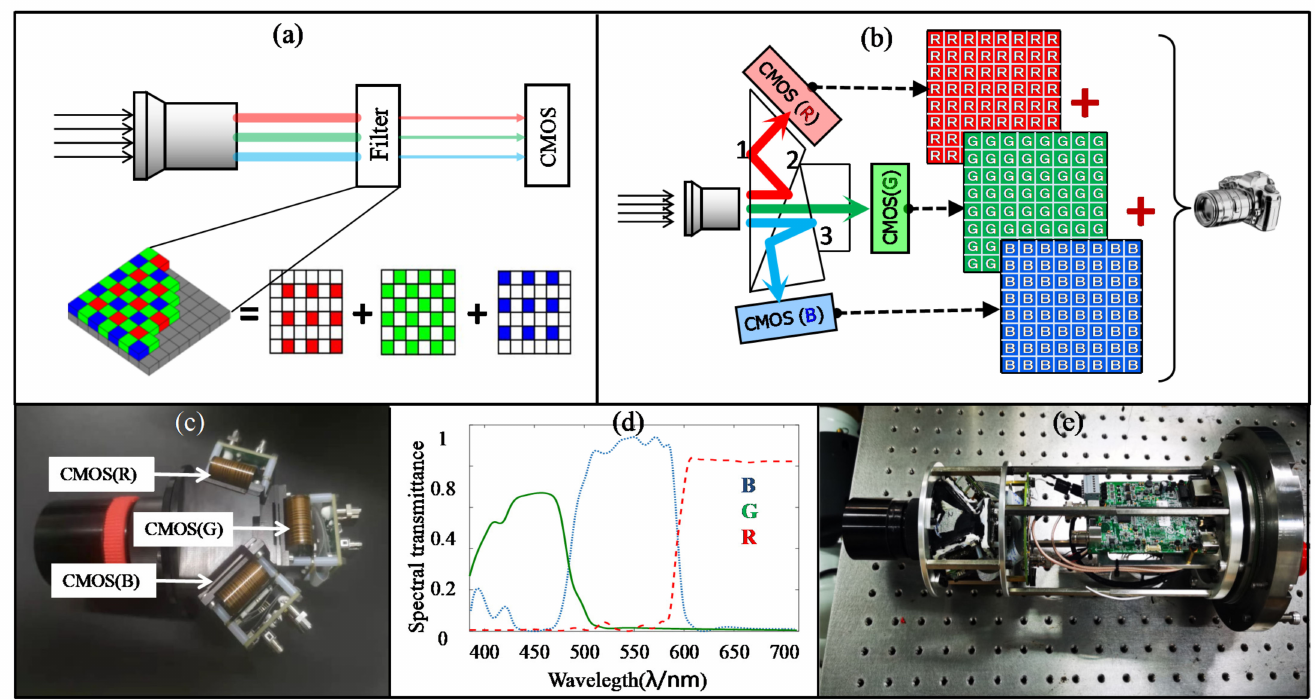
Figure 4. The design of the 3 × CMOS RGB camera: ( a ) the imaging principle of traditional color; ( b ) the imaging principle of traditional of 3 × CMOS RGB camera; ( c ) the photo of spectral structure with prism; ( d ) the transmittance curve of R, G, and B channels; ( e ) the photo of the 3 × CMOS RGB camera movement.